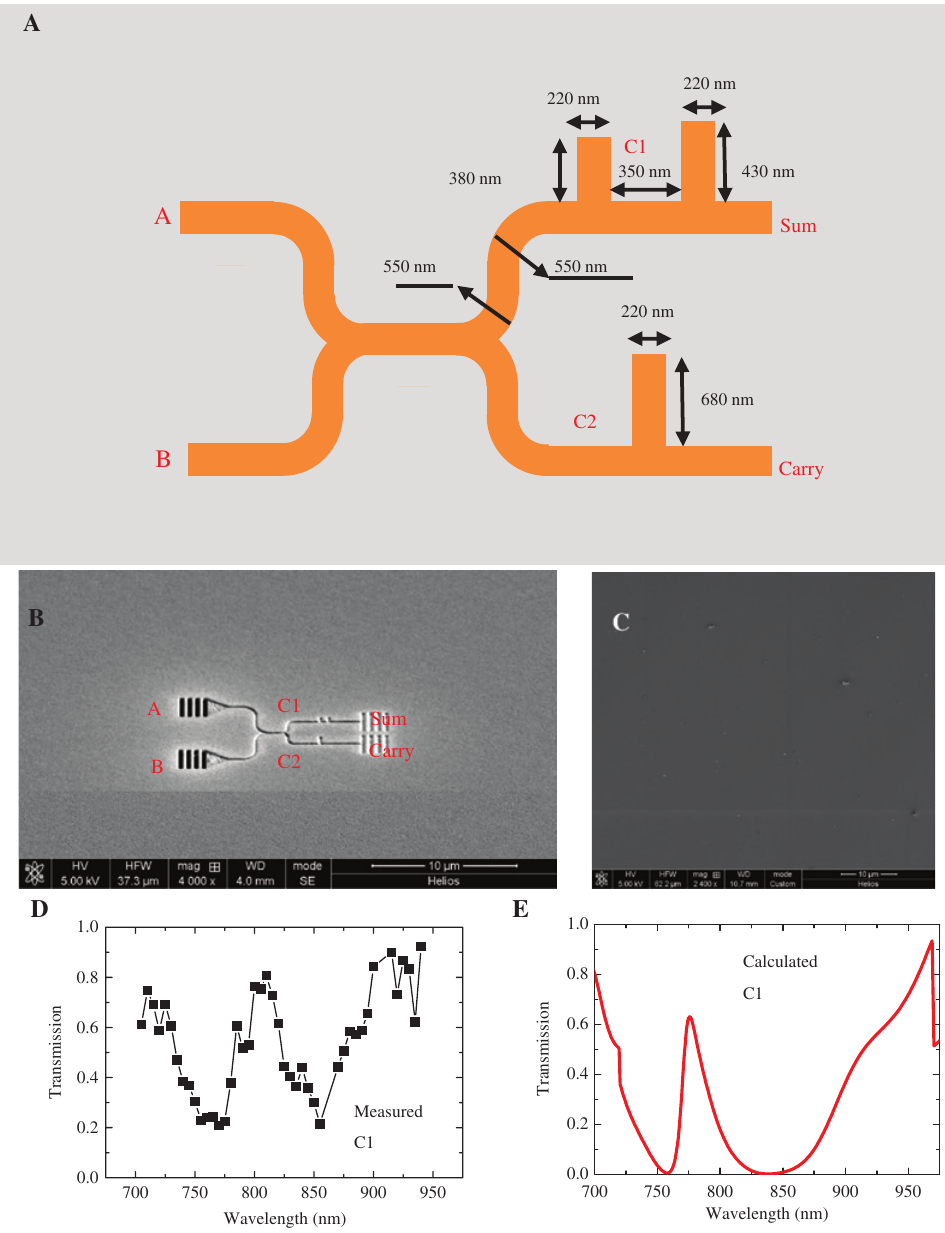
Figure 1: Characterization of the half-adder sample and performances of the logic function. (A) Schematic structure of the half-adder